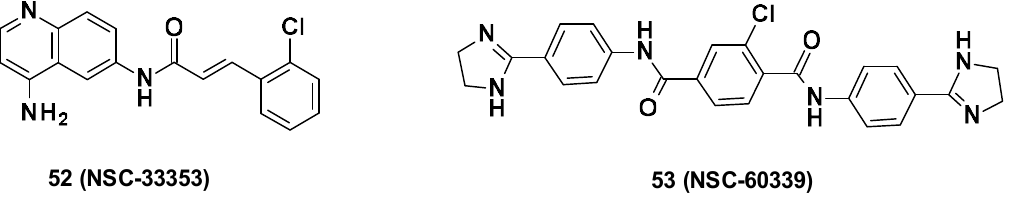
Figure 9. Structure of NSC-33353 and NSC-60339.